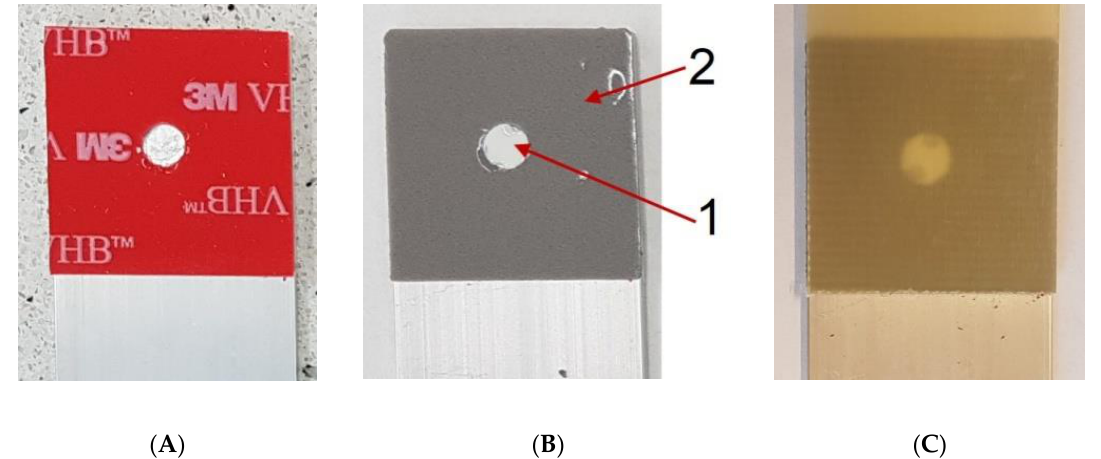
Figure 2. Example of dual adhesive sample preparation. ( A ) double side adhesive tape and liquid epoxy application; ( B )removing of protective film and ( C ) adding a second adherend.